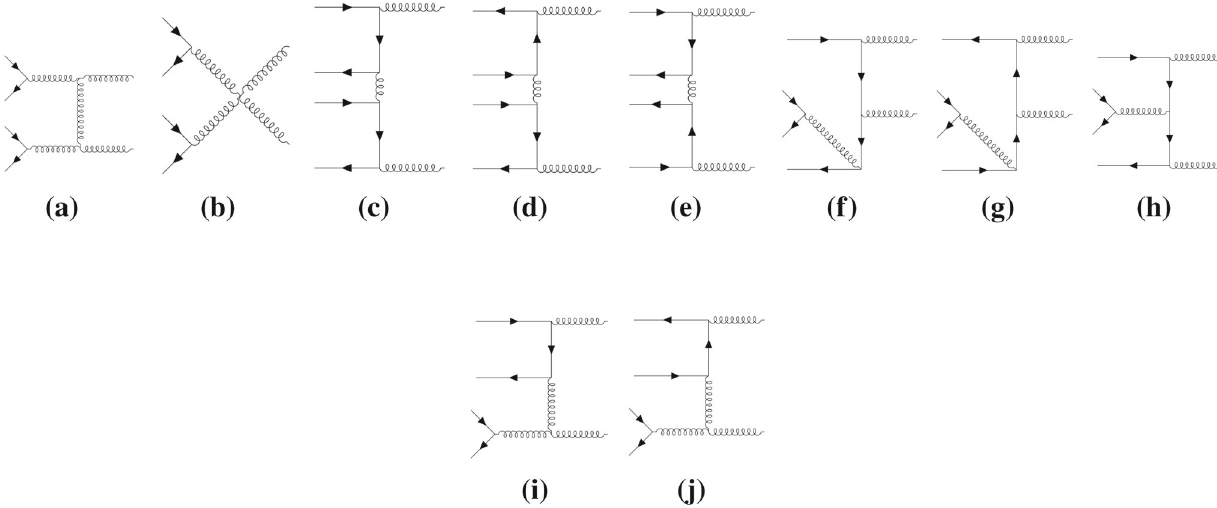
Fig. 2 The transition T ↔ 2